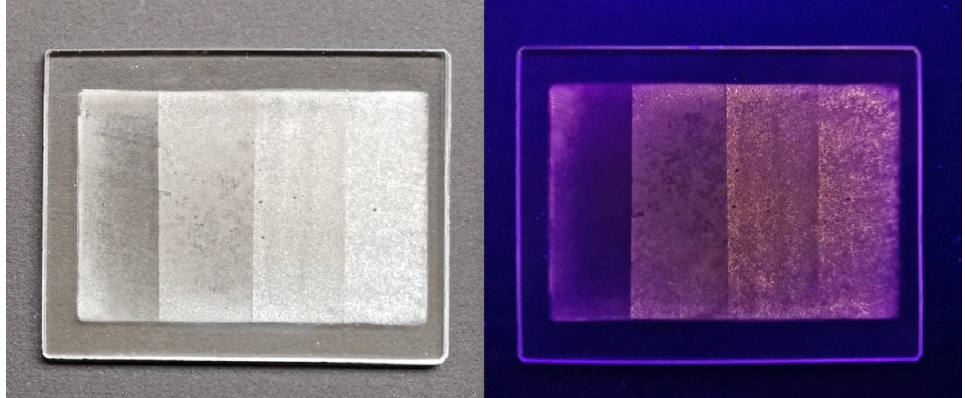
Figure 6. Aquatint etching with sodalite zeolite composite, transfer print on glass. Sample viewed with visible light ( left ), sample viewed with UV light ( right ). Author’s photos. Figure created by author.